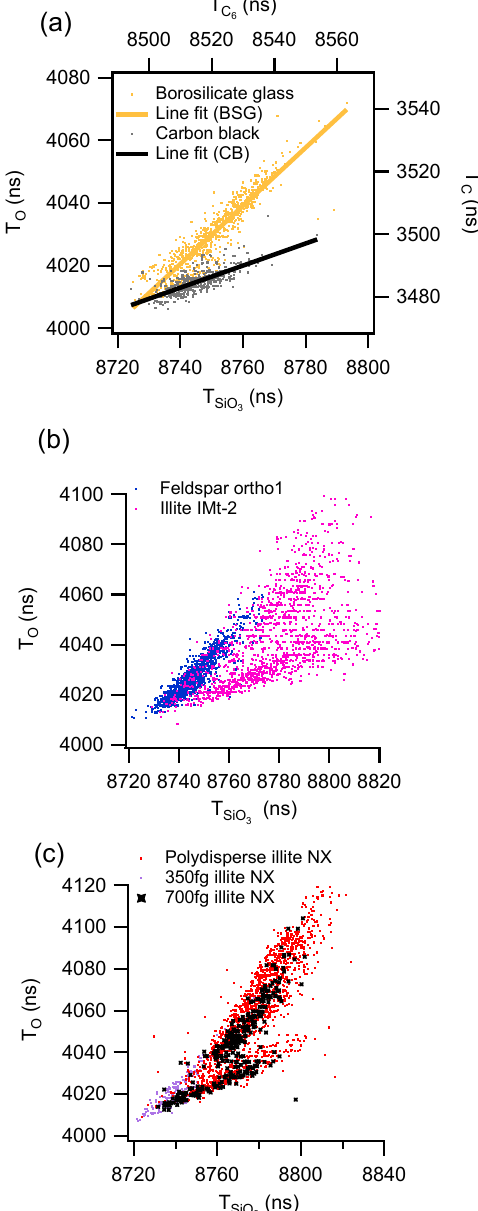
Figure 7. Ion arrival times ( T ( i ) ) of elemental ions compared to molecular ion species in negative ion mode. Each point represents a single-particle measurement: (a) 2.1µm borosilicate glass spheres and polydisperse carbon black, (b) polydisperse orthoclase feldspar and illite IMt-2 and (c) polydisperse illite NX and mass selected illite nx particle with the